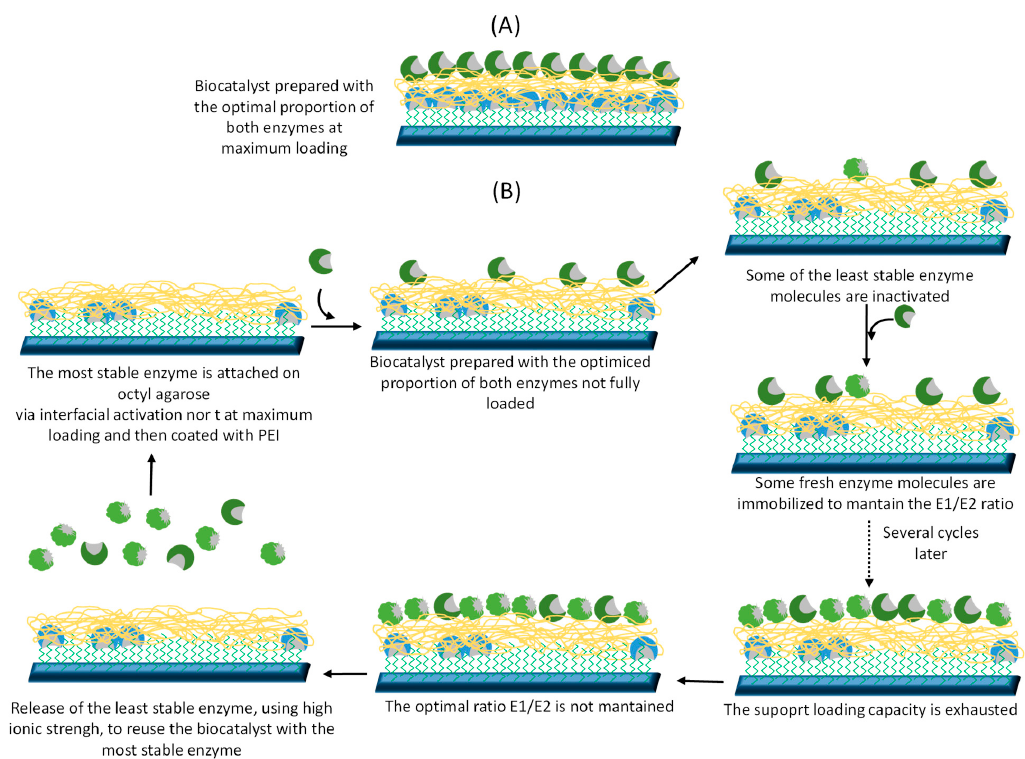
Figure 7. Compatibility of the combi-biocatalysts prepared following Figure 6 with the strategy